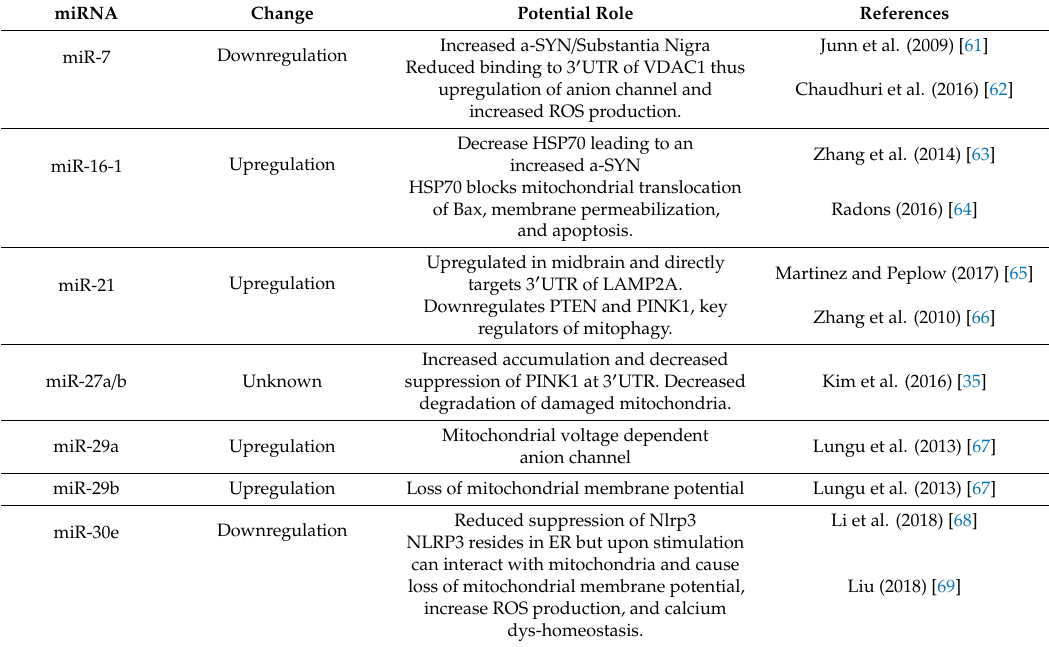
Table 2. Mitochondrial microRNAs related to Parkinson’s